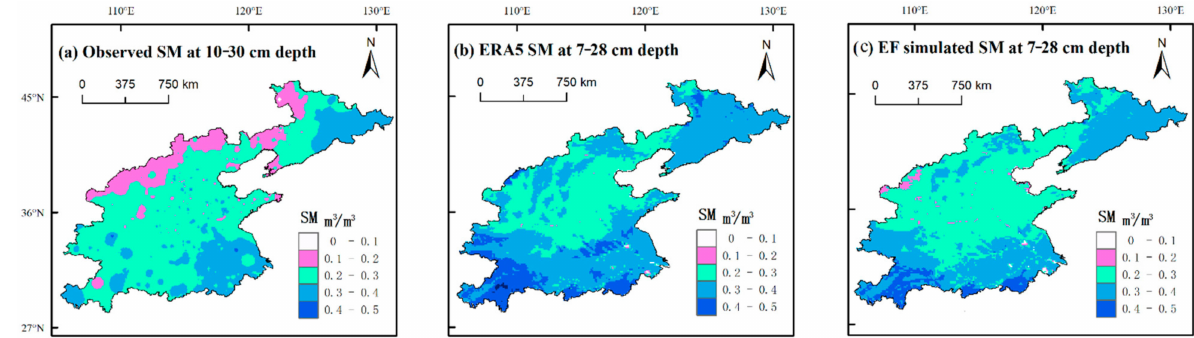
Figure 5. Spatial comparison of ERA5-provided and ERA5-derived RZSMs (7–28 cm) compared to the in situ ground RZSM observations (10–30 cm). (Herein, the average of SM observations at each station was calculated from 2006–2017, and spatially interpolated through Kriging